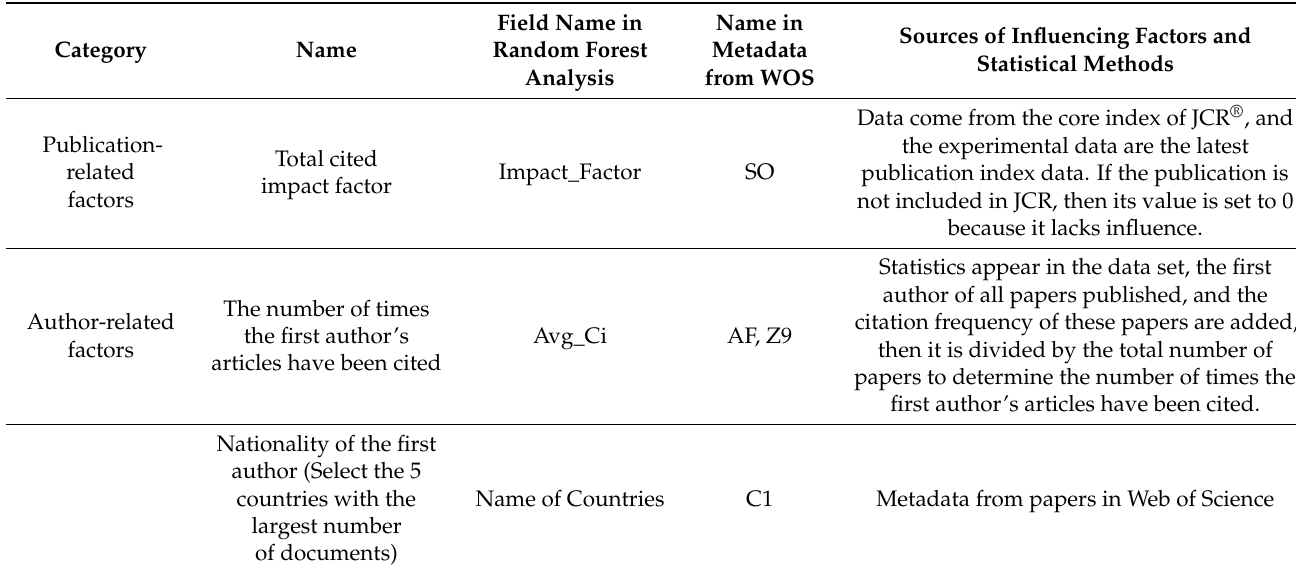
Table 1. Table of influencing